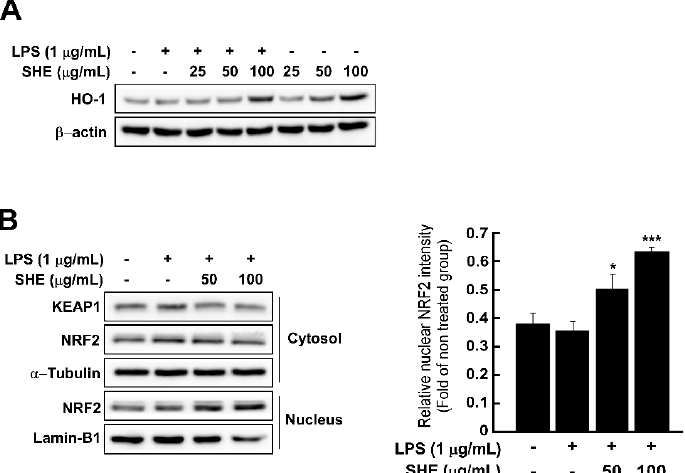
Figure 5. Effects of Soroseris hirsuta extract (SHE) on the nuclear factor erythroid 2-related factor 2 (NRF2) and heme oxygenase-1 (HO-1) pathway in RAW 264.7 cells. ( A ) SHE increased HO-1 dose- dependently with or without LPS. Before the cells were treated for 6 h with LPS, SHE was treated for 1 h. ( B ) Western blotting of nuclear and cytoplasmic fractions. Fractionation was performed as described in Materials and Methods section. LPS was treated for 4 h, and SHE was treated 1 h earlier. * p < 0.05 and *** p < 0.001. The data represent the mean ± SD of three separate